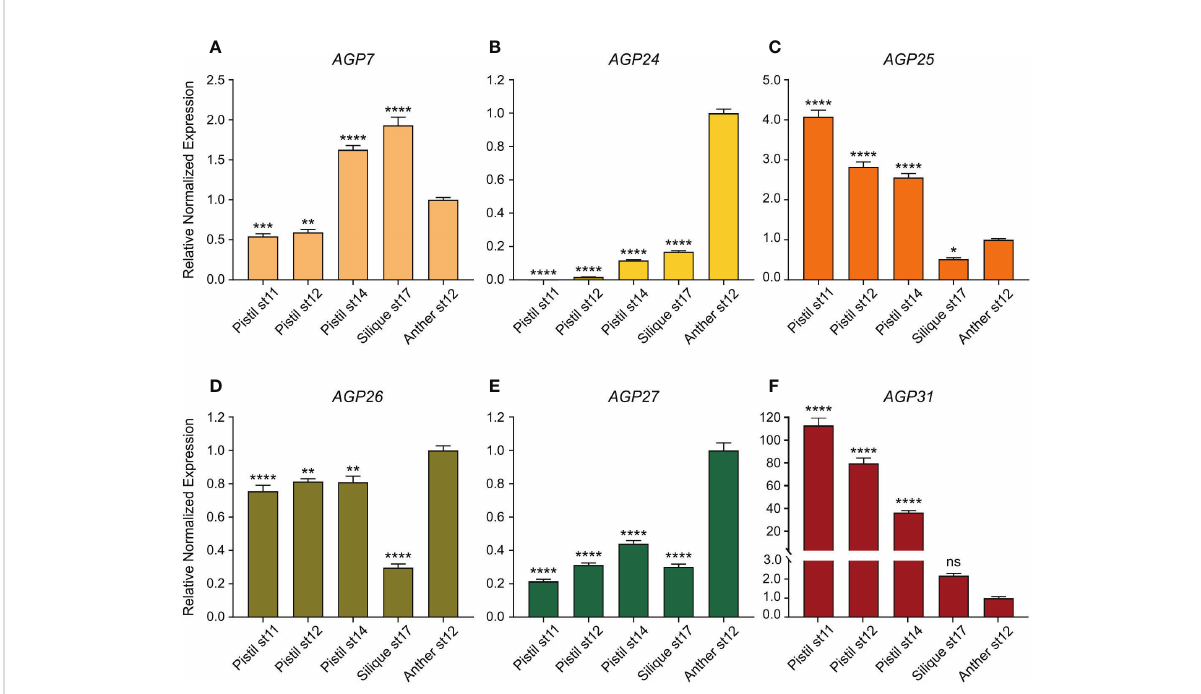
FIGURE 5 Relative normalized expression levels of AGP7, AGP24, AGP25, AGP26, AGP27 and AGP31 in reproductive tissues. (A) Relative normalized expression level of AGP7 in reproductive tissues. (B) Relative normalized expression level of AGP24 in reproductive tissues. (C) Relative normalized expression level of AGP25 in reproductive tissues. (D) Relative normalized expression level of AGP26 in reproductive tissues. (E) Relative normalized expression level of AGP27 in reproductive tissues. (F) Relative normalized expression level of AGP31 in reproductive tissues. The transcript levels were normalized to RCE1, TUA2 and YLS8 reference genes. The data correspond to the ratio of the expression compared with anther stage 12 (st12) (Smyth et al., 1990). Error bars represent the standard error of the mean (SEM) of three independent biological replicates, each with three technical replicates. Statistical analyses were performed using a one-way ANOVA followed by Dunnett ’ s multiple comparisons test. Asterisks indicate value signi fi cantly different from anther st12 expression (*, p<0.033; **, p<0.002; ***, p<0.0002; ****, p<0.0001; ns, not signi fi